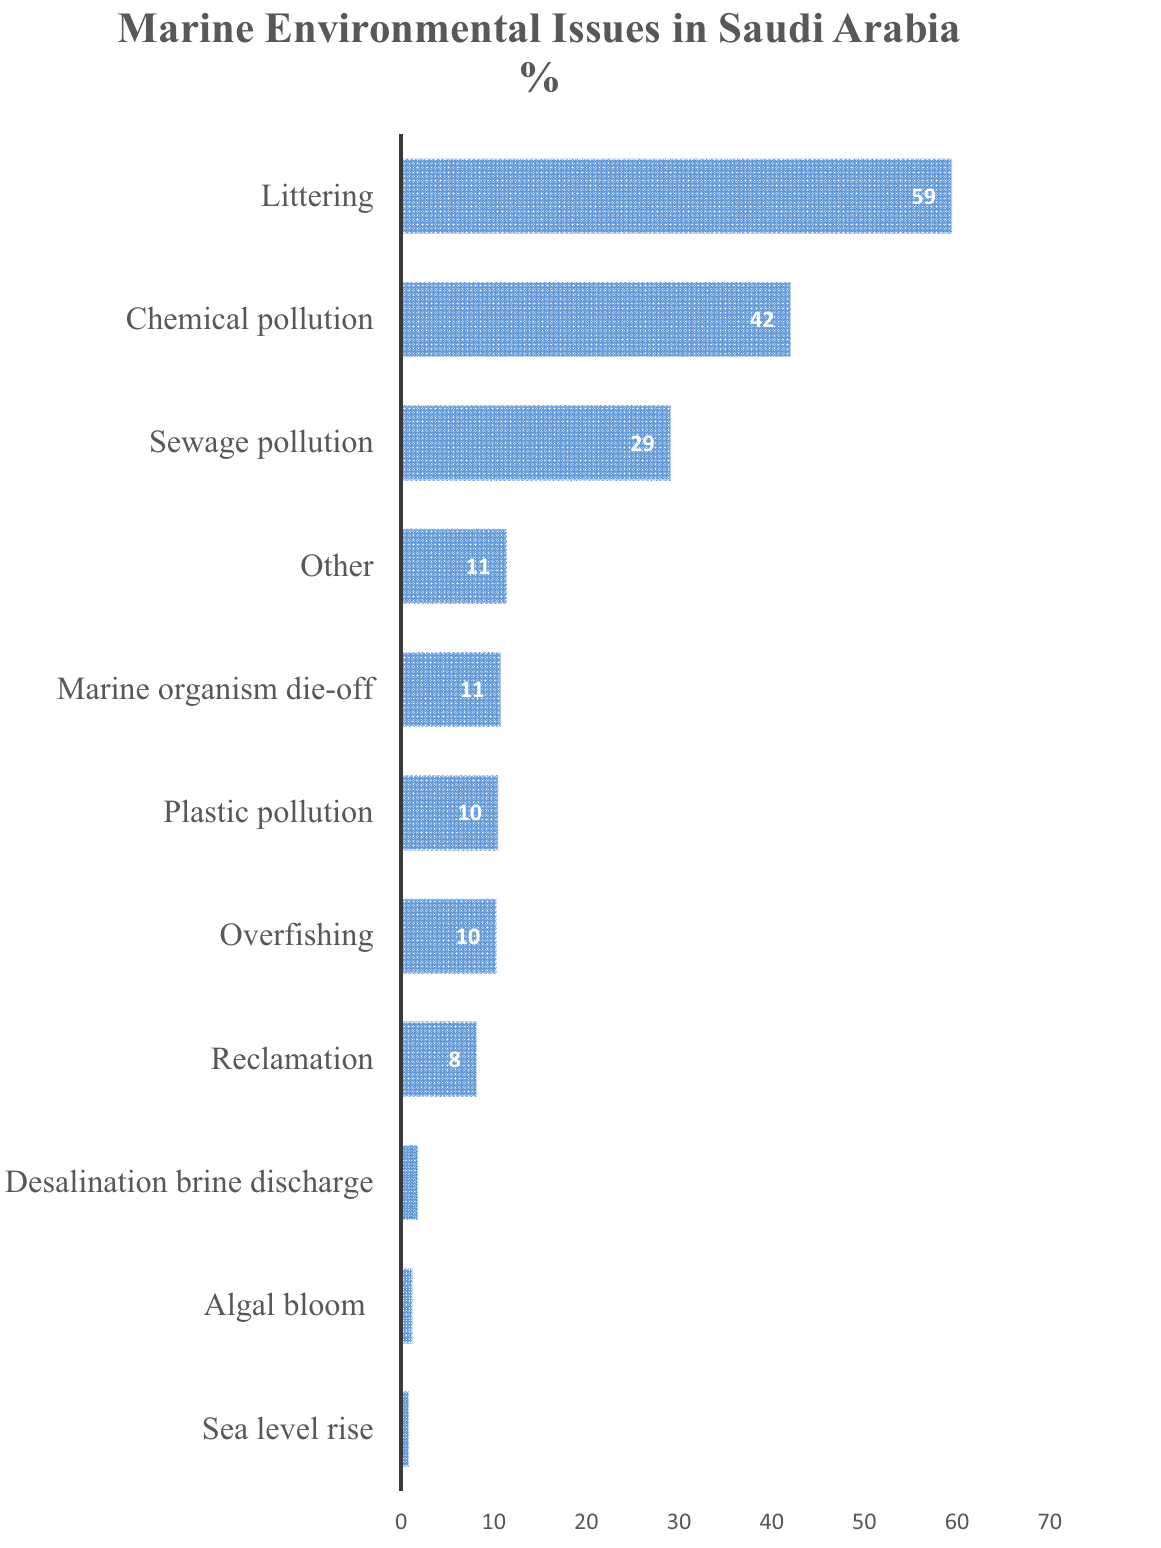
Frontiers in Marine Science |